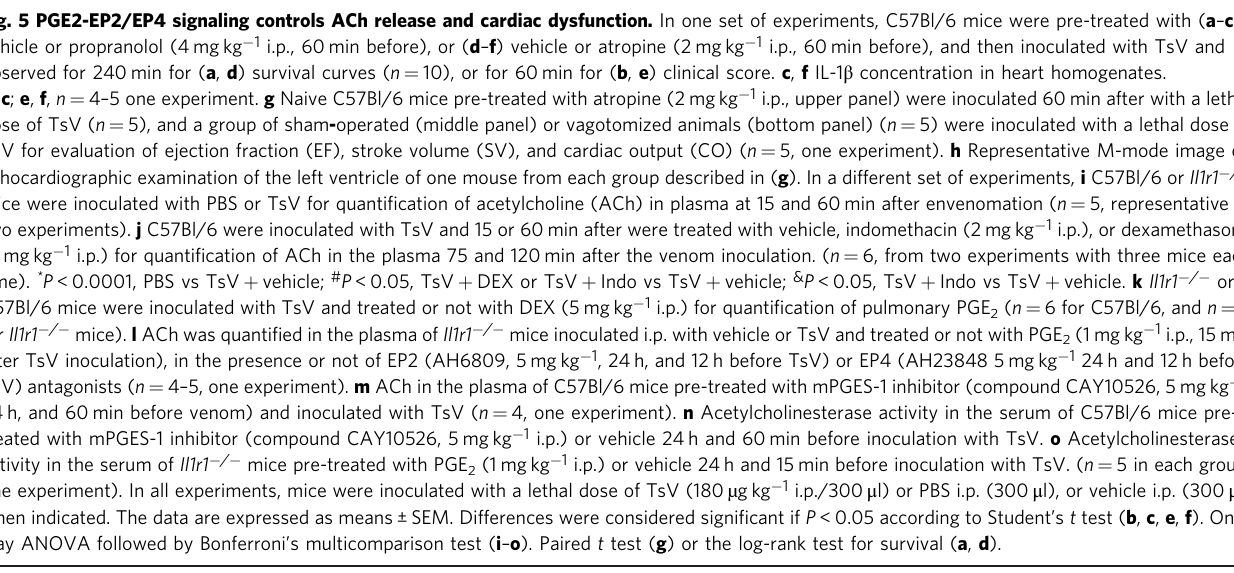
Fig. 5 PGE2-EP2/EP4 signaling controls ACh release and cardiac dysfunction. In one set of experiments, C57Bl/6 mice were pre-treated with ( a – c